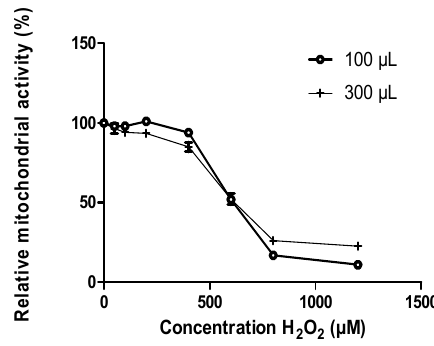
Figure 1. E ff ects of H 2 O 2 on ARPE-19 cells. Plates were seeded with 100 or 300 µ L per well of cell suspensions at 2.10 5 cells / mL After 3 days, cells were treated with H 2 O 2 for 2 h. Metabolic activity was evaluated by MTT assay. Results are presented as relative mean metabolic activity ± SEM.